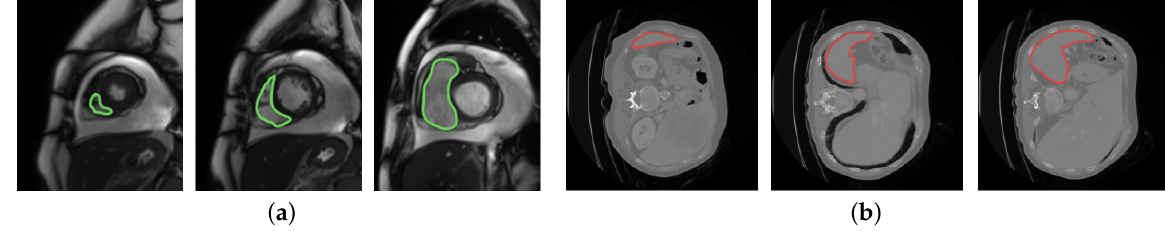
Figure 1. The diversity of image features in two example tissue types: heart ( left ) and spleen ( right ). The image features are segmented by green and red lines in the heart and spleen, respectively. ( a ) Heart; ( b )